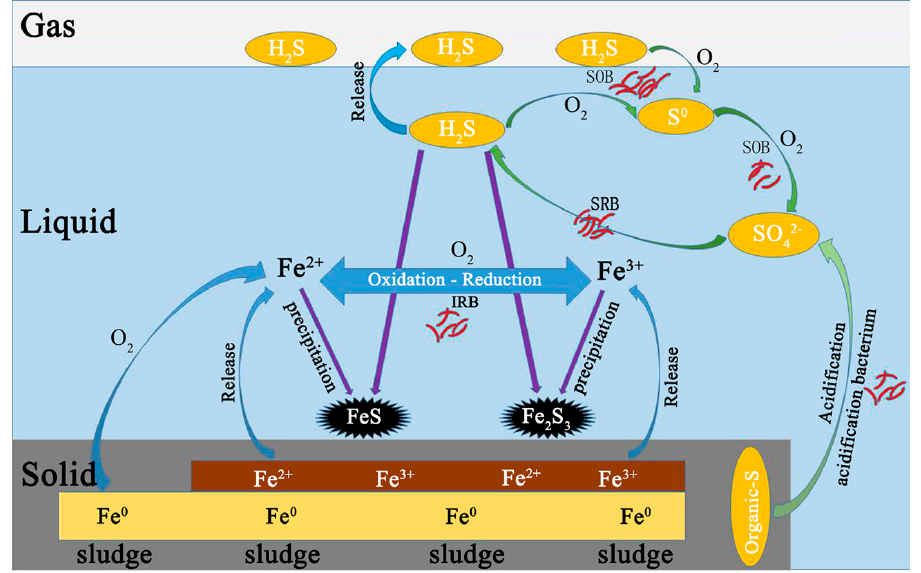
Figure 6. The possible desulfurization mechanisms by combination of RSI and micro-oxygen during digestion system. digestion